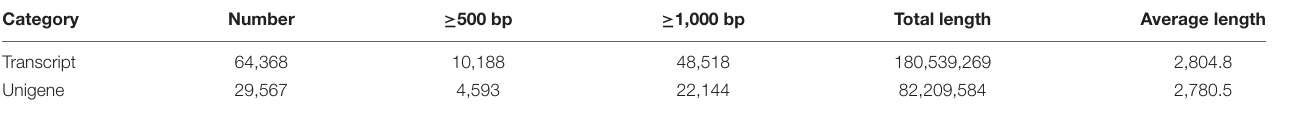
TABLE 3 | Statistics of assembly